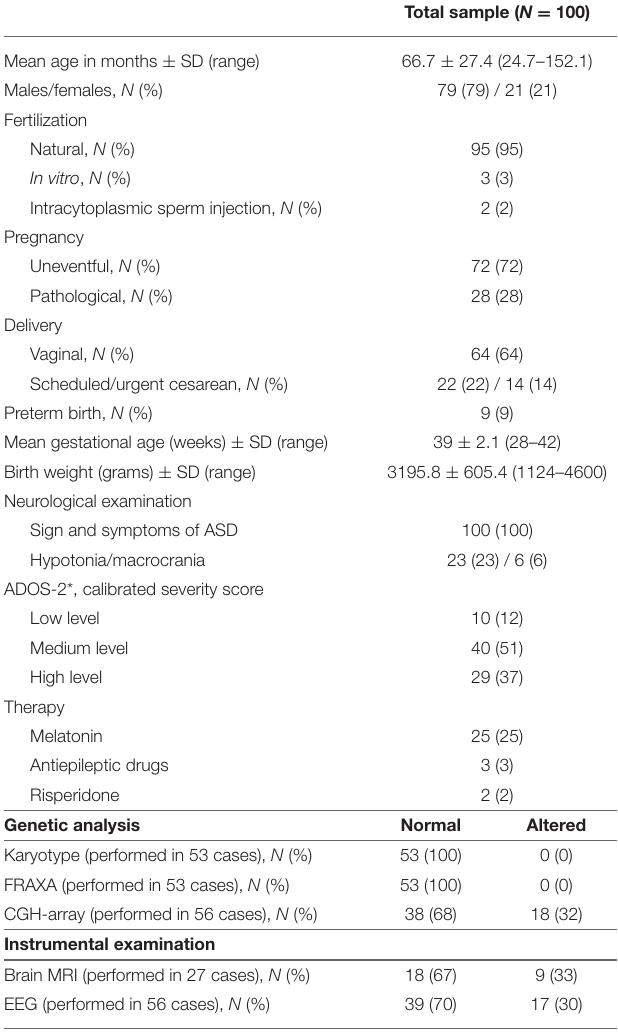
TABLE 2 | Demographic, clinical, and genetic/instrumental data of the total